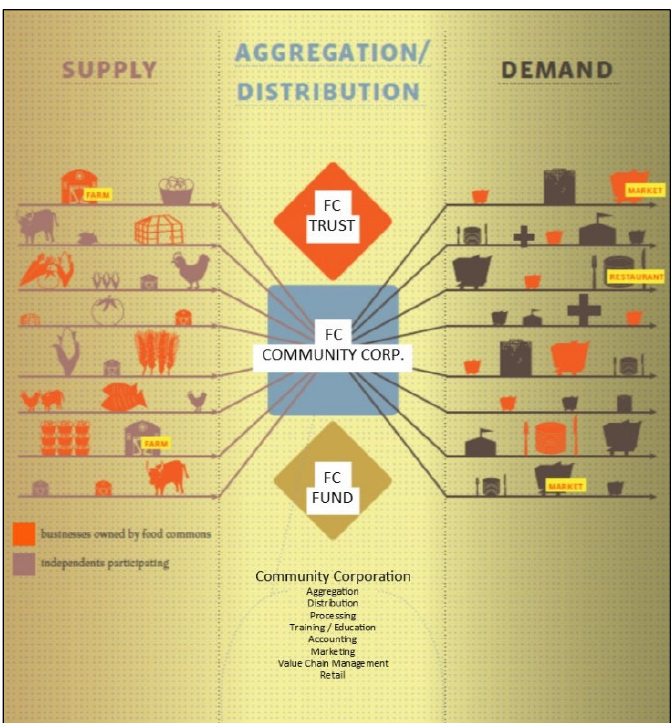
Figure 3. The Food Commons’ Vertical